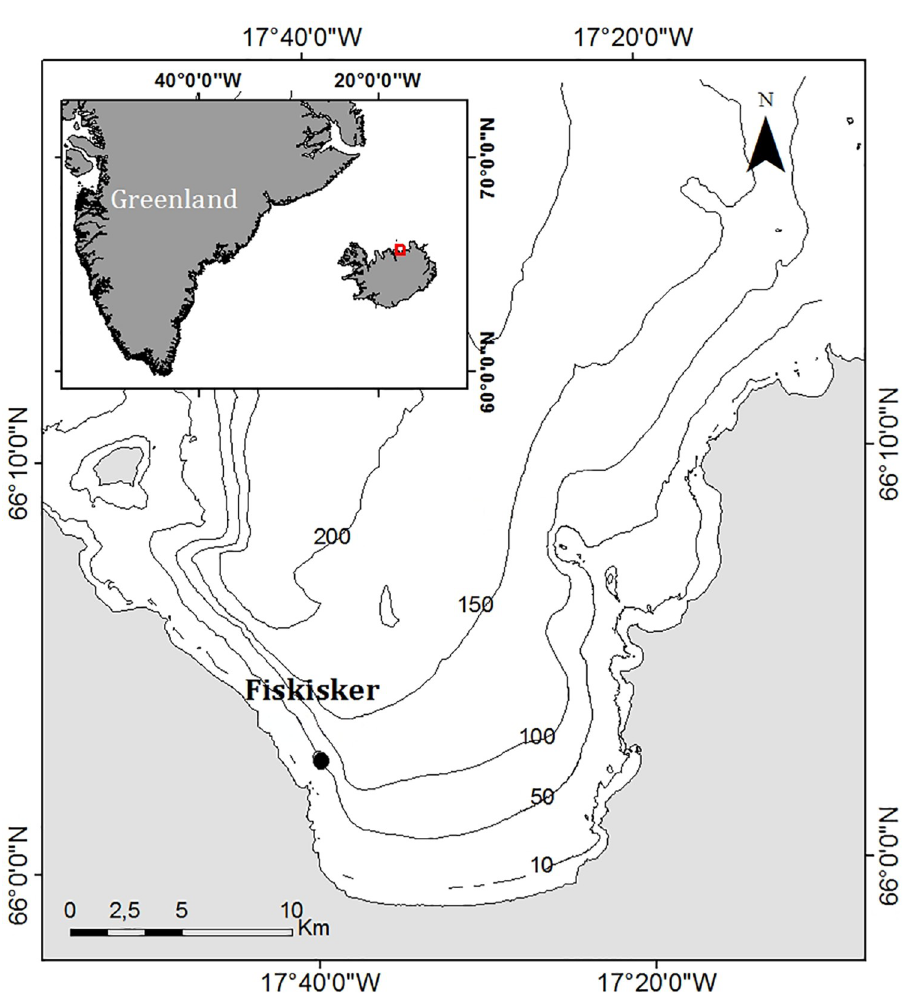
Fig 2. The study area in Skja´lfandi bay, NE Iceland. The black circle represent the location of the EAR recording unit at Fiskisker (66˚03’N, 17˚40’W). Depth contours are in meters. Source (1) Hydrographic Department of the Icelandic Coast Guard, 2012, (2) National Land Survey of Iceland, 2012 and (3) Esri, DeLorme Publishing Company, Inc. The map was created using ArcGIS_ software (version 10.1) by Esri. Adapted with permission from Magnu´sdo´ttir et al .